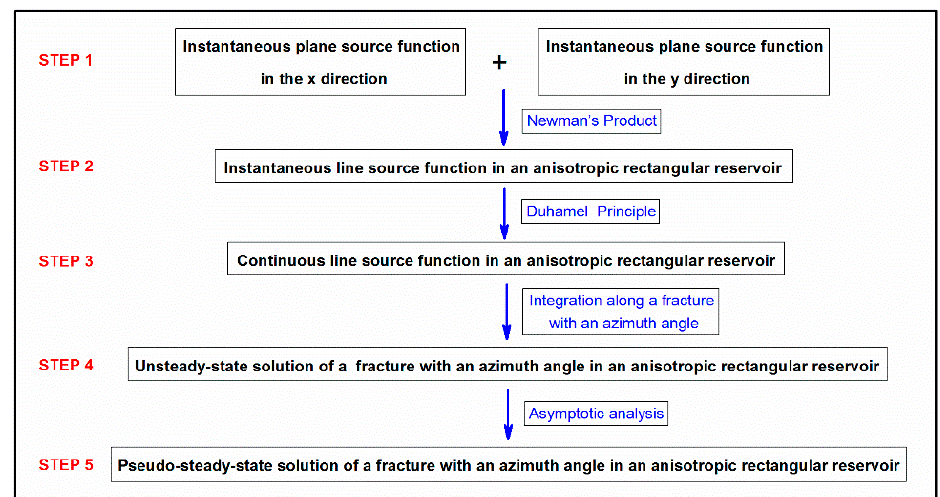
Figure 2. Derivation process of pseudo-steady-state solution of a fracture with an azimuth angle in an anisotropic rectangular reservoir.